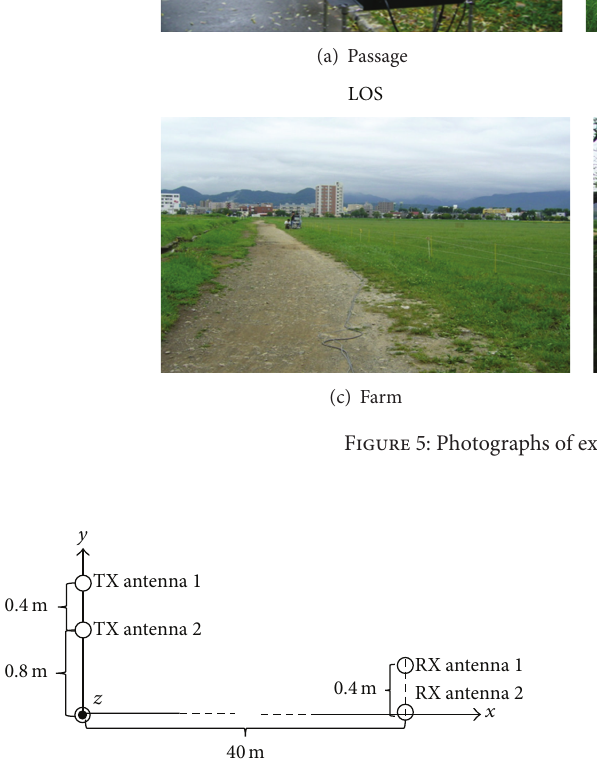
Figure 6: Antenna location of transmitter and receiver antennas.